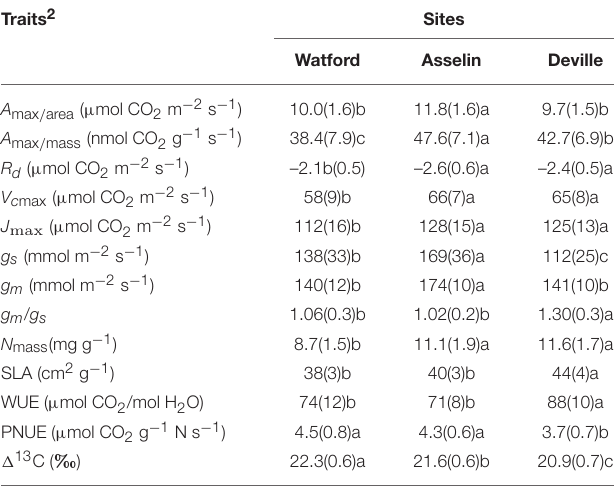
TABLE 3 | Differences in functional traits among the three plantation sites 1 . Traits 2